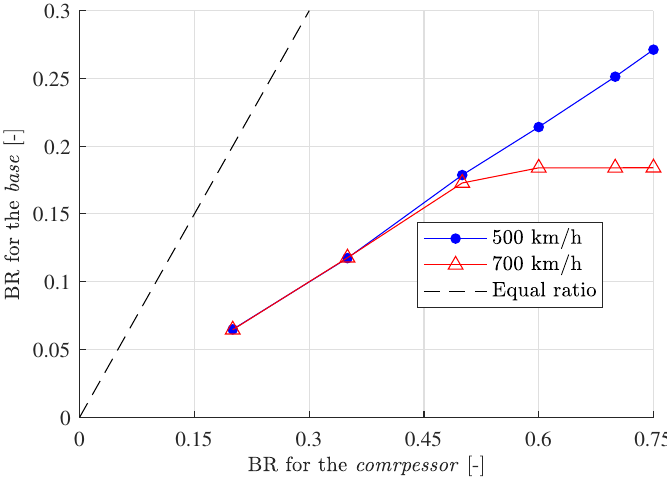
Figure 15. Blockage ratio comparison for the case with and without